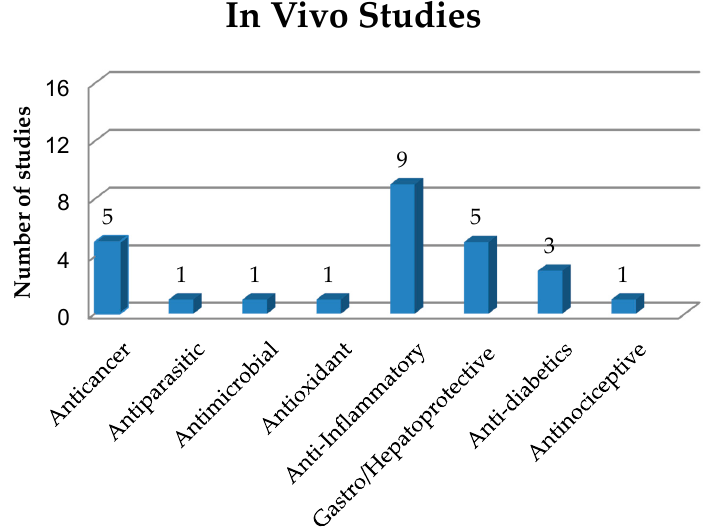
Figure 4. Quantification and classification of in vivo studies on solid dispersions published in the period from 2009 to 2020.